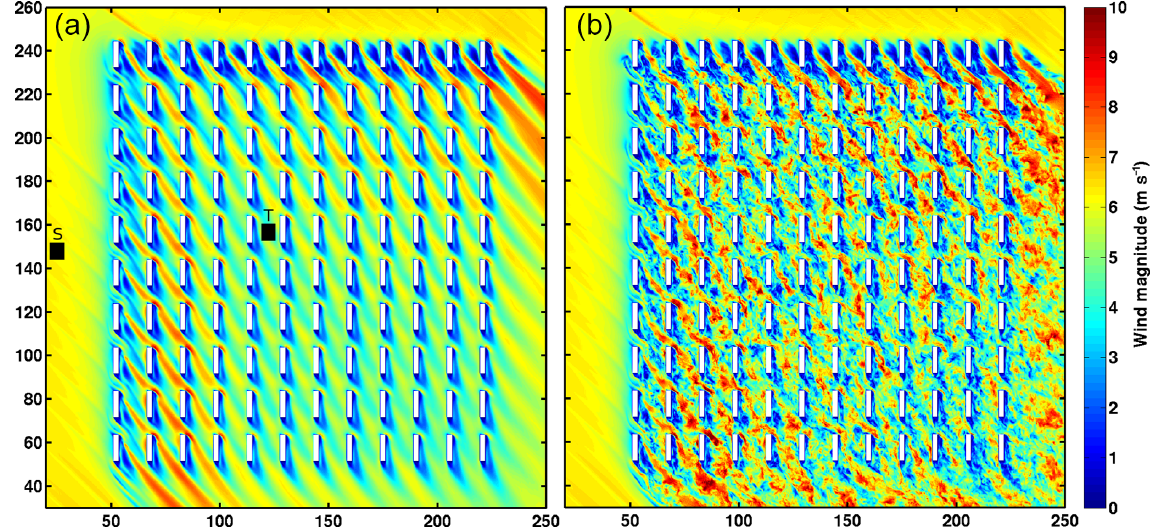
Figure 18. Wind at the horizontal cut at z = 1 . 6m: (a) time-averaged on 200s; (b) instantaneous at t = 200s. The black squares indicate the location of the T and S towers (MNH–IBM results). Table 2. Kinetic energy, turbulent kinetic energy and friction velocity obtained by the experimental (Yee and Biltoft, 2004) and numerical (MNH–IBM) investigations at three altitudes of the tower